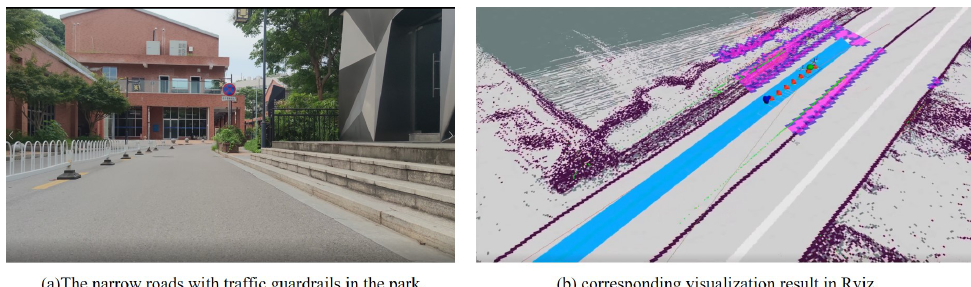
Figure 15. The real-world experiment. The blue line is the global reference path. The curve composed of red arrows is the result of the motion trajectory. The blue arrow represents the local target generated by NRTEB planner. The green sphere represents the tracking point selected in the local trajectory for the